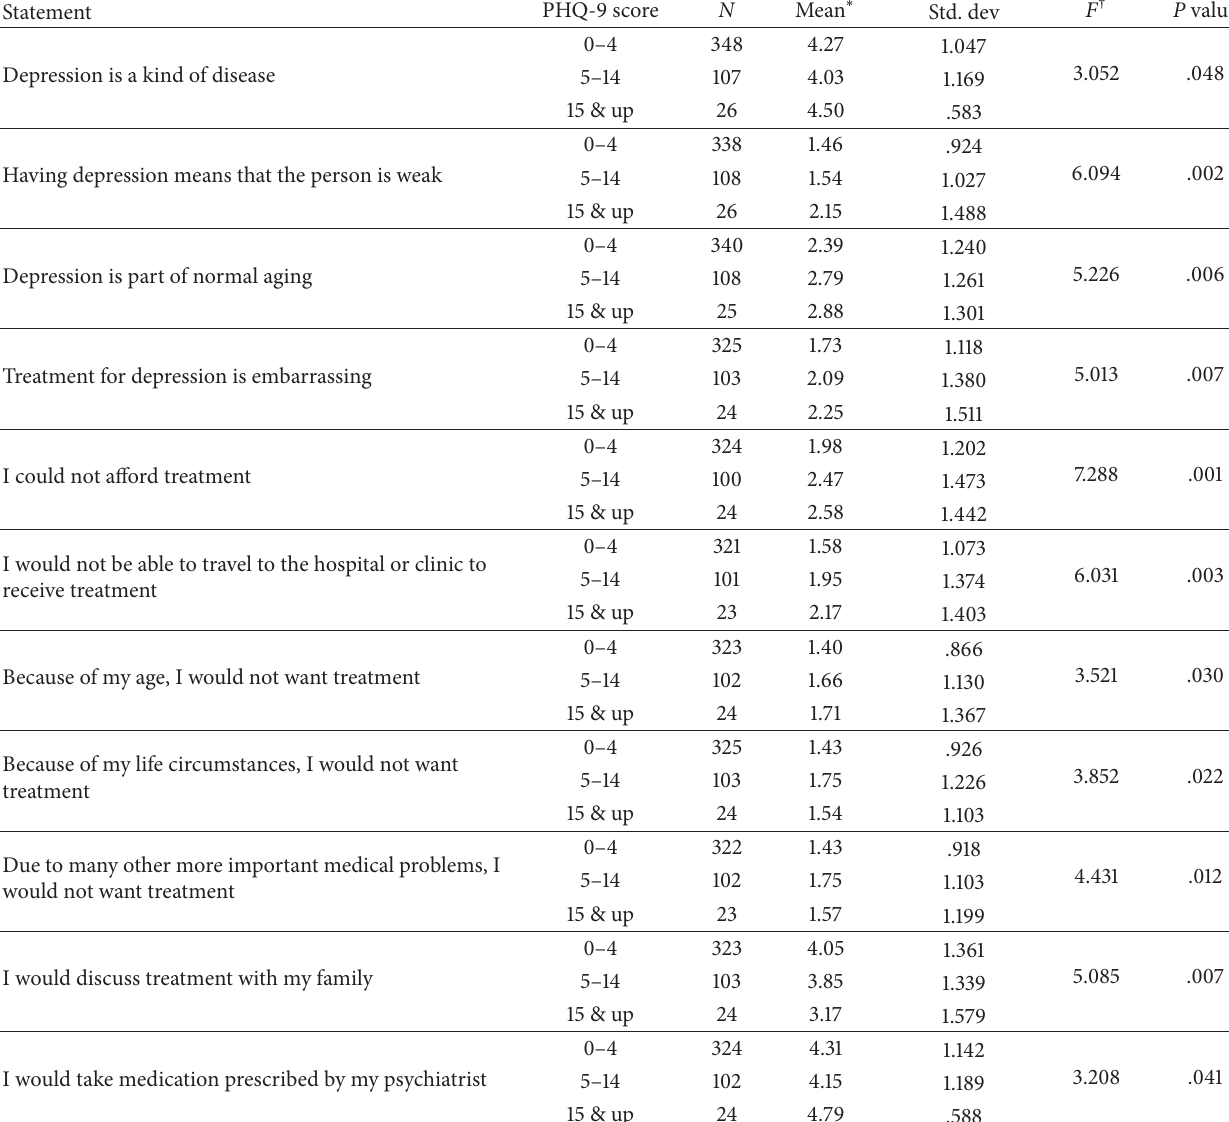
Table 4: Depressive symptoms and associations with attitudes about depression and